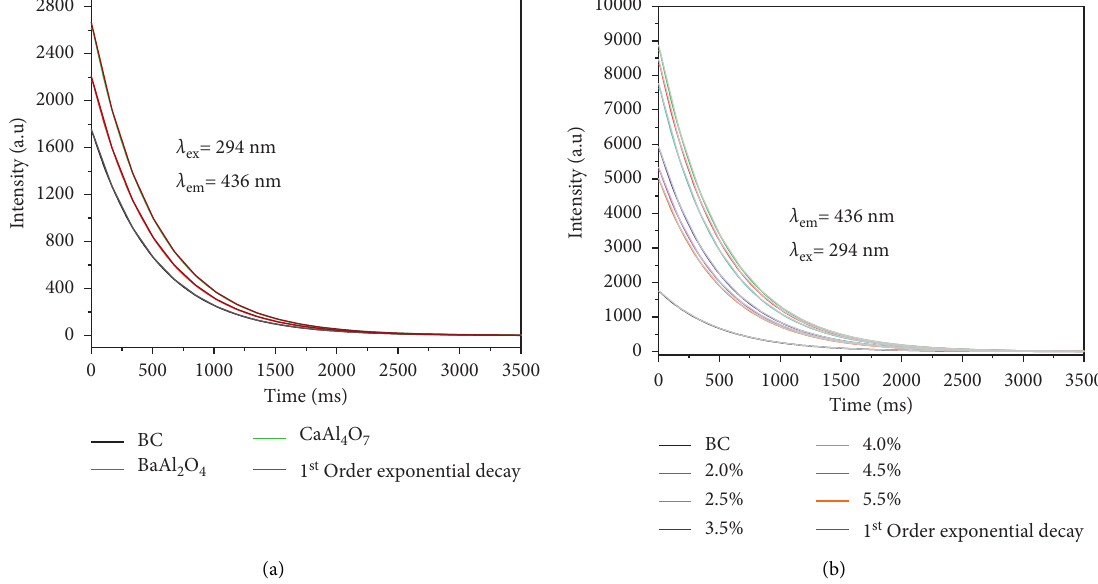
Figure 9: Decay curves of Eu 3+ emission monitored at 436nm for (a) BaAl phosphors under excitation at